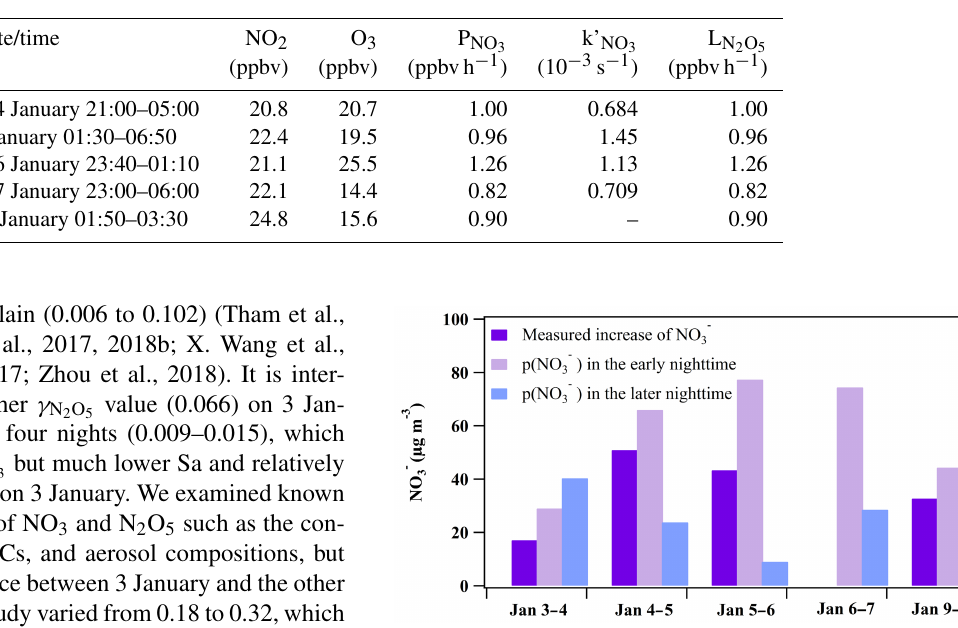
Table 3. Average values of the N 2 O 5 loss rate and related parameters for selected periods in the later nighttime.